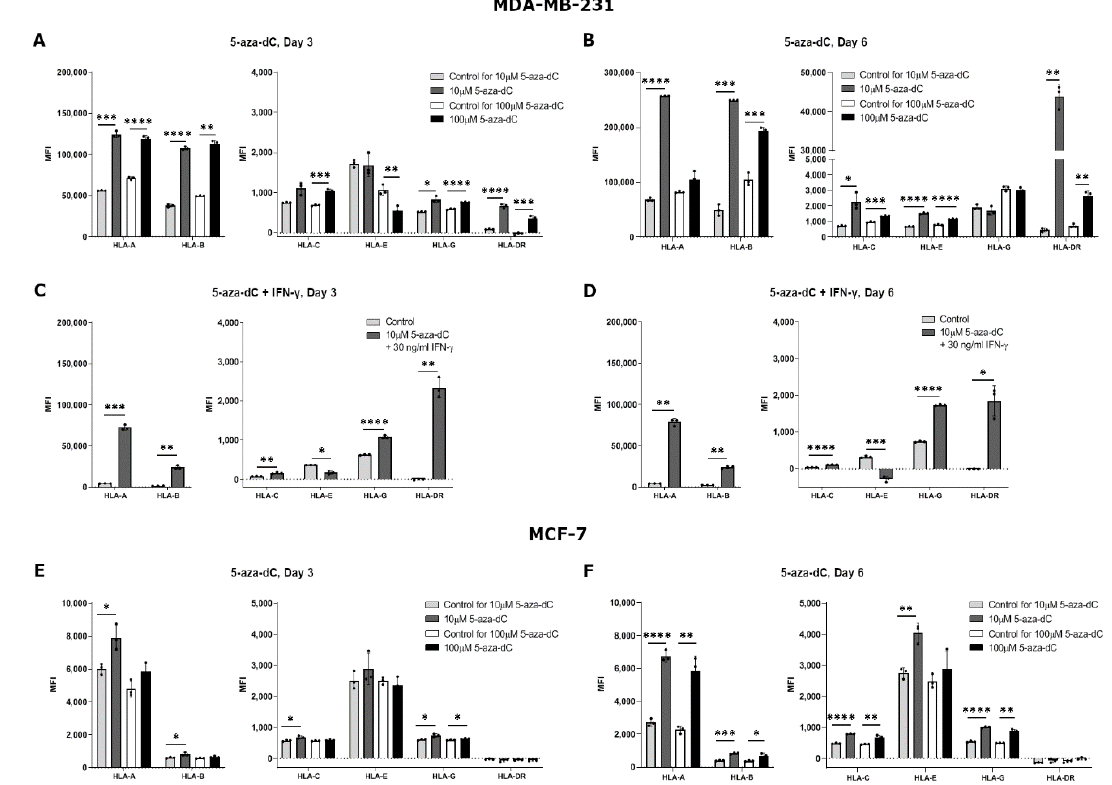
Figure 3. HLA surface expression on breast cancer cell lines stimulated with 5-aza-2′-deoxycytidine (5-aza-dC). Flow cytometry analysis of HLA-A, HLA-B, HLA-C, HLA-G, HLA-E, and HLA-DR expression. ( A , B ) MDA-MB-231 cells treated with either 10 µM or 100 µM 5-aza-dC for three ( A ) and six days ( B ). ( C , D ) MDA-MB-231 cells treated with 10 µM 5-aza-dC and 30 ng/mL IFN-γ for three ( C ) and six days ( D ). ( E , F ) MCF-7 cells treated with either 10 µM or 100 µM 5-aza-dC for three ( E ) and six days ( F ). Shown are median fluorescence intensity (MFI) with mean ± SD, each dot represents one sample. The shown MFI level of control samples represent a combination of background and baseline expression. * p < 0.05, ** p < 0.01, *** p < 0.001, **** p < 0.0001 (Student’s unpaired t-test with Welch’s correction).